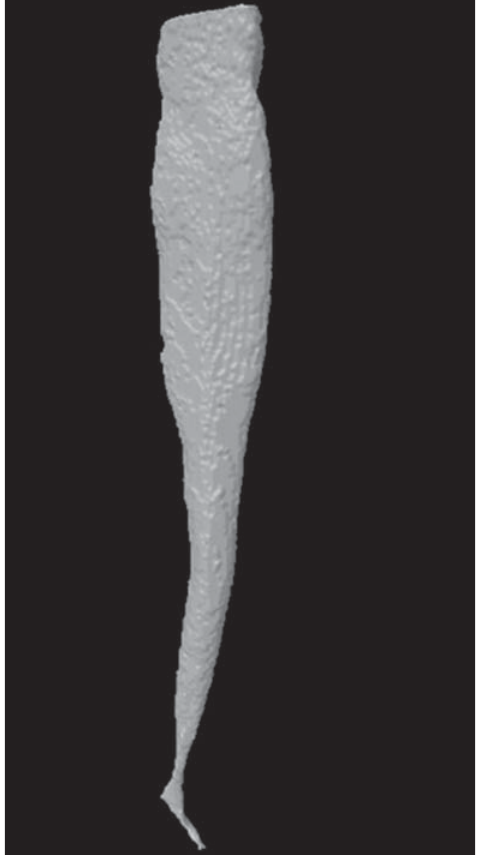
Figure 4- Image of a 3D model of the root canal after automatic Table 1- Mean and standard deviation of canal volume and canal surface using different segmentation methods